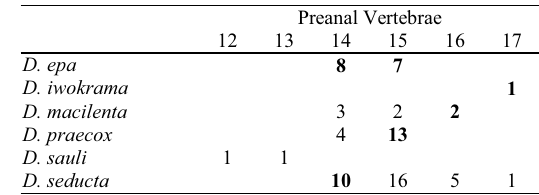
Table 19 . Number of specimens of the species of Dentice- topsis with cited number of preanal vertebrae. Bold indicates values for holotype when available. Value for D. royeroi , known only from holotype which could not be radiographed, unavailable.